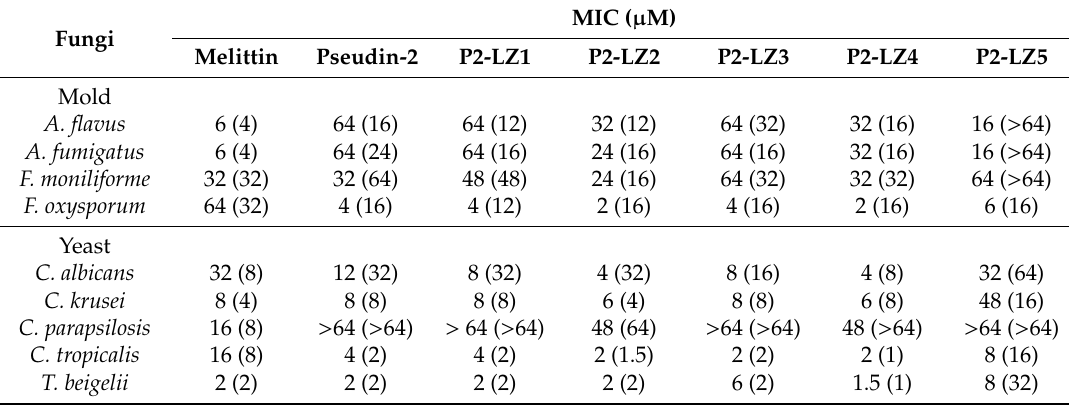
Antifungal assays were performed in 10 mM sodium phosphate buffer (pH 7.2) and 10 mM MES buffer (pH 5.5) supplemented with culture medium. The values in parentheses are MICs under acidic Table 2. Antifungal activities of pseudin-2 and its derivatives against mold and yeast cells. conditions.